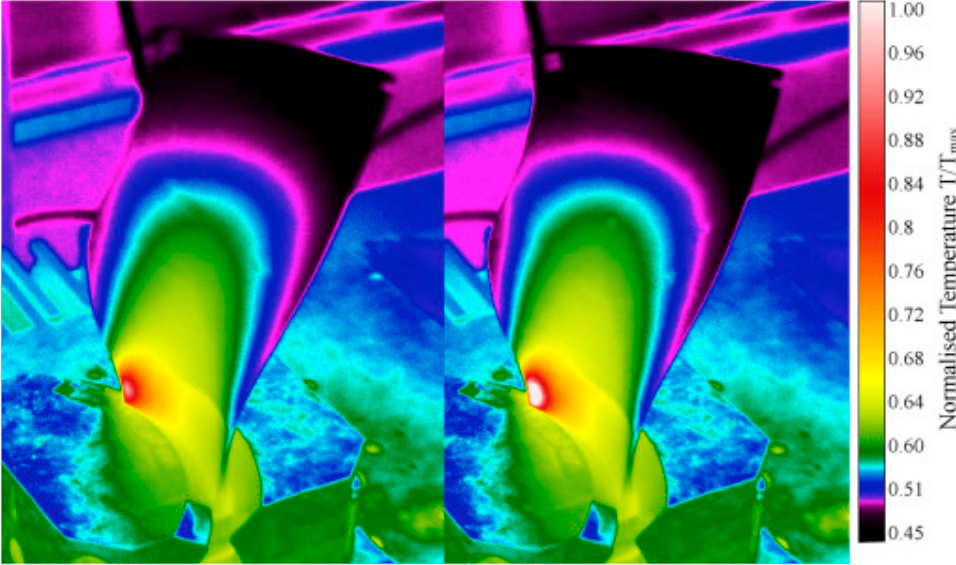
Figure 45. An exemplary illustration of dominating self-heating process in a composite blade: ( left ) before and ( right ) after the occurrence of the critical self-heating temperature, adapted with permission from Ref. [28]. Copyright © 2016 Elsevier